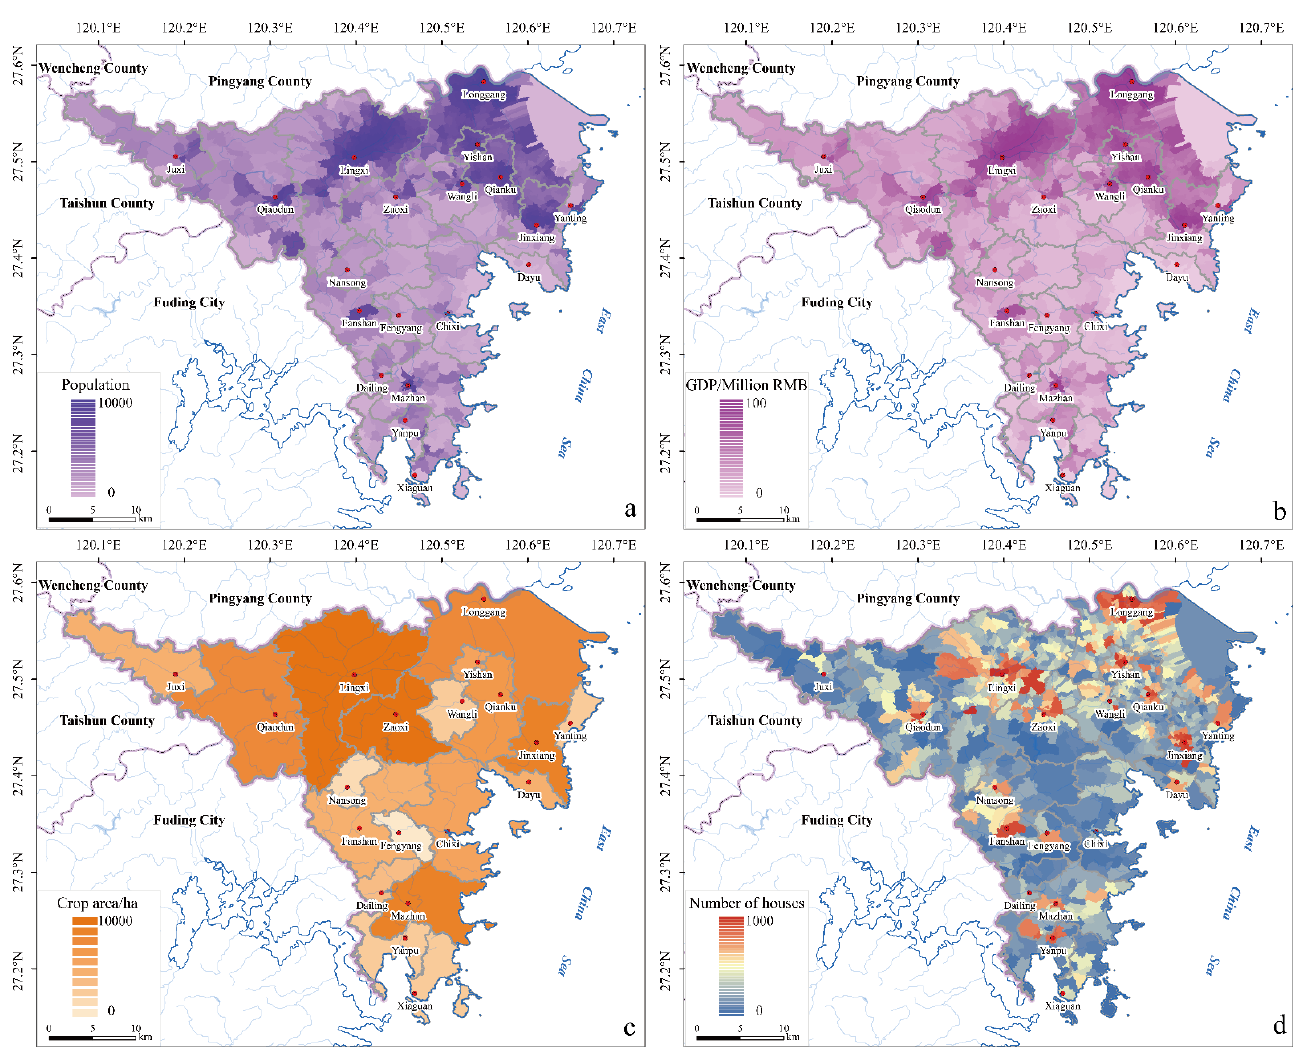
Figure 3. Spatial distribution of ( a ) population, ( b ) gross regional product, ( c ) crop areas, and ( d ) houses in Cangnan County.